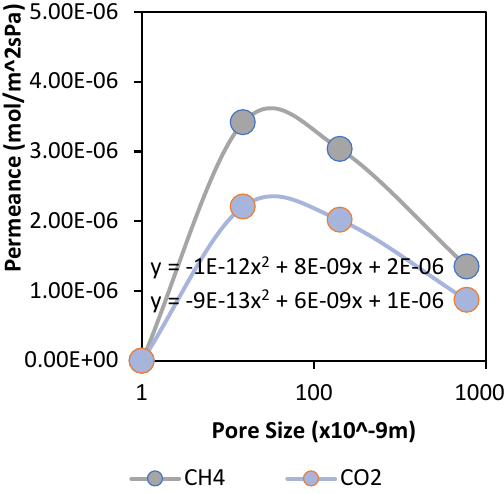
Figure 2. Effect of membrane pore size on gas permeance at 3 bar and 20 °C.